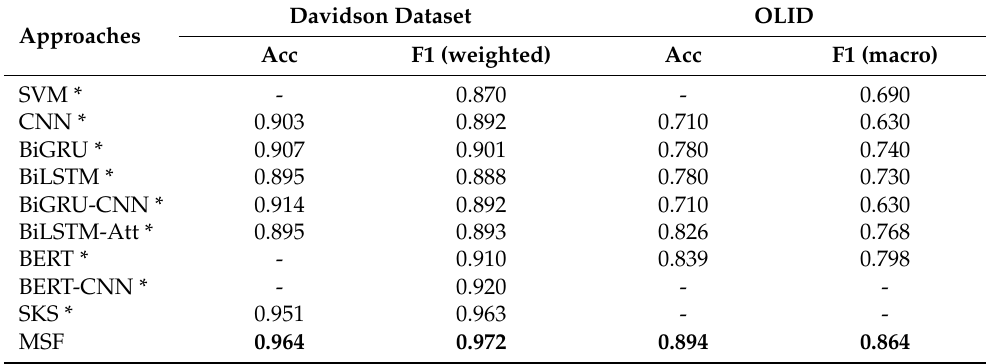
Table 3. The performance of the proposed method MSF and other baseline methods are compared. Davidson Approaches